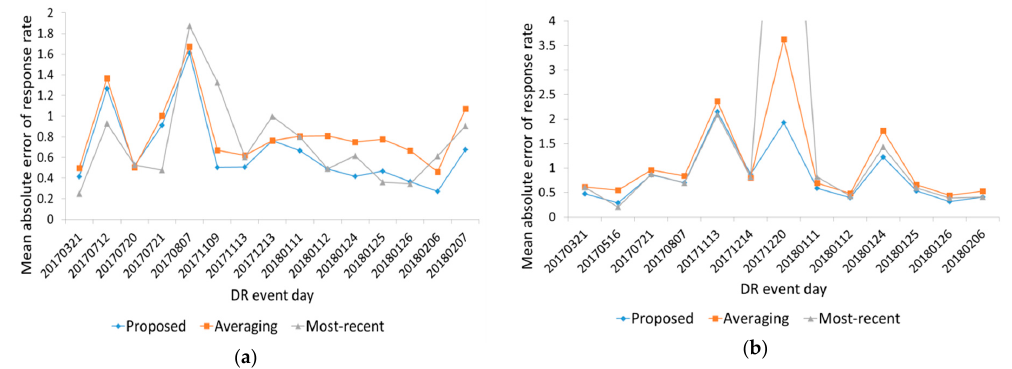
Figure 8. Prediction error comparison for each DR event day. ( a ) Customer set A (From service provider A); ( b ) Customer set B (From service provider